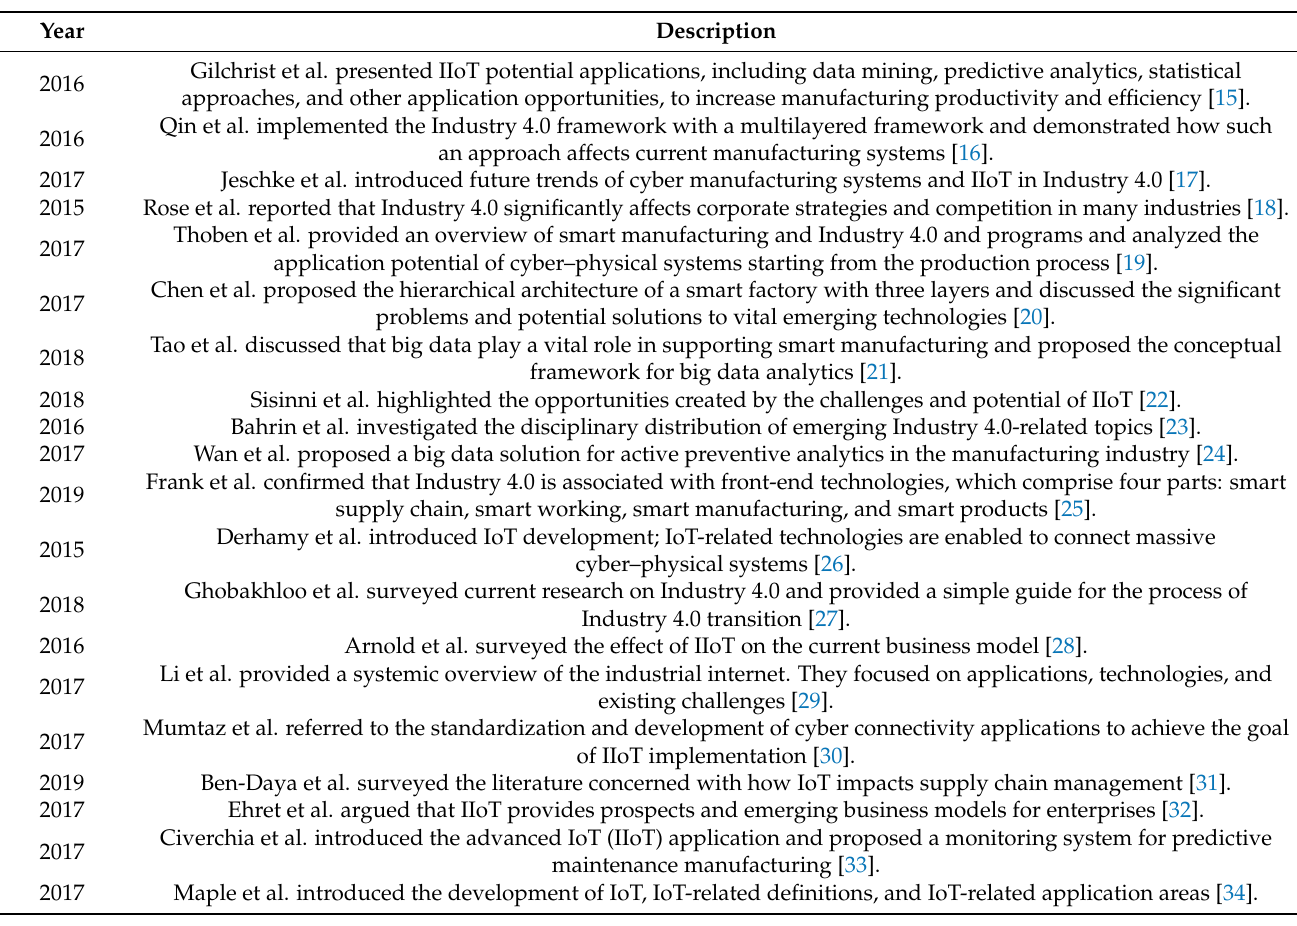
Table 1. IIoT-based PdM-related studies from 2015 to